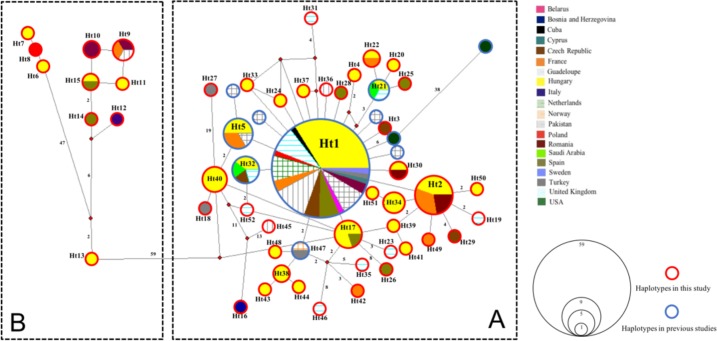
Median-joining network based on the joint data set (present and GenBank sequences) from mtDNA COI region of Streptopelia decaocto.The Figure contains original as well as published sequences. Each circle represents a haplotype with the size proportional to the frequency of collapsed sequences. Solid branches connecting circles represent nucleotide changes among haplotypes. Numbers on branches represent the number of mutational steps between haplotypes. Absence of numbers is equivalent to a single mutational event. Colours and patterns within circles illustrate the relative frequencies of sequences from different geographic areas.